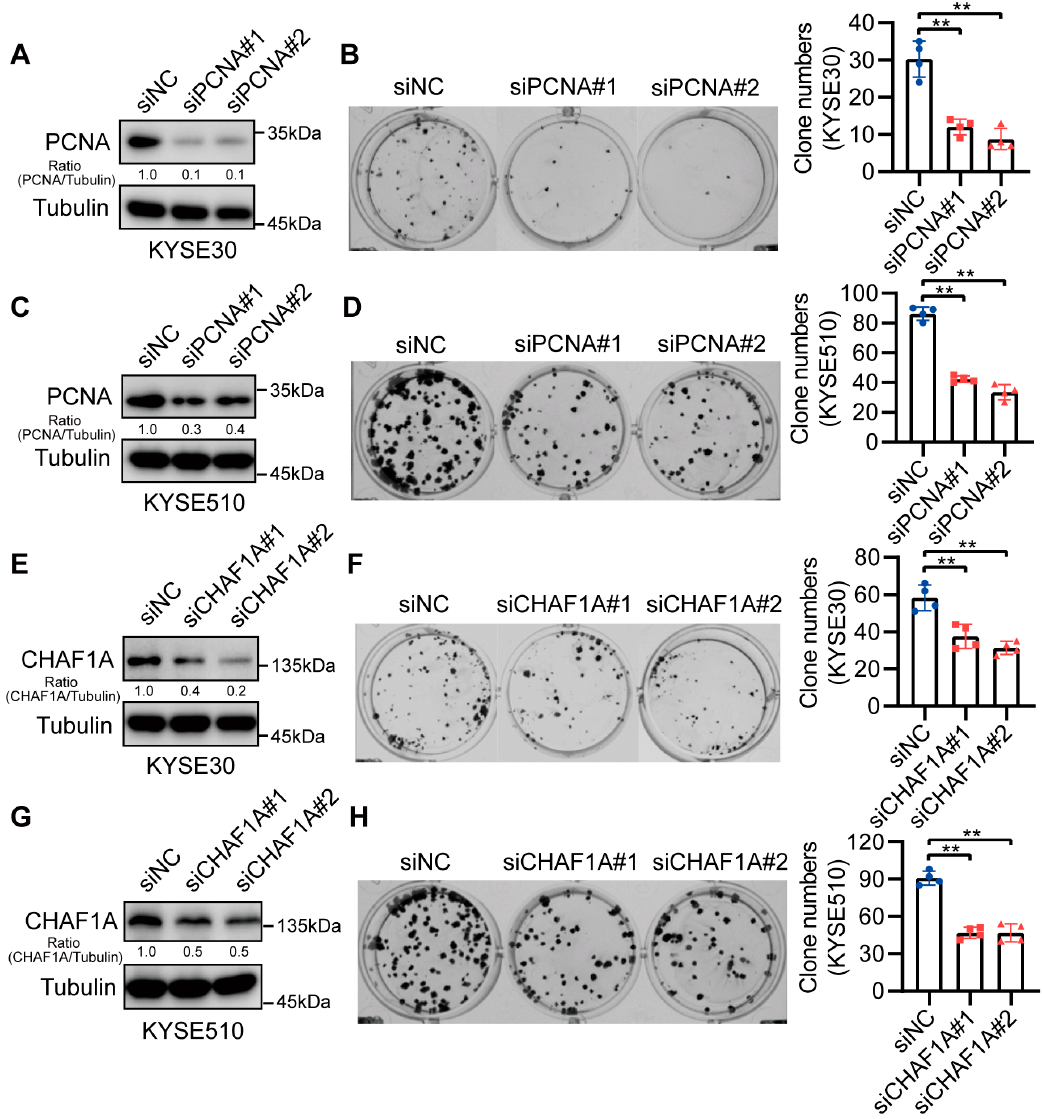
Figure 3. CHAF1A and PCNA knockdown reduce EC cell proliferation. ( A , C , E , G ) Western blot analysis of PCNA or CHAF1A knockdown in KYSE30 and KYSE510 cell lines. ( B , D ) Representative images (left) and colony quantification (n = 4; right) of KYSE30 cells ( B ) and KYSE510 cells ( D ) with PCNA knockdown. ( F , H ) Representative images (left) and colony quantification (n = 4; right) of KYSE30 cells ( F ) and KYSE510 cells ( H ) with CHAF1A knockdown. ** p < 0.01.